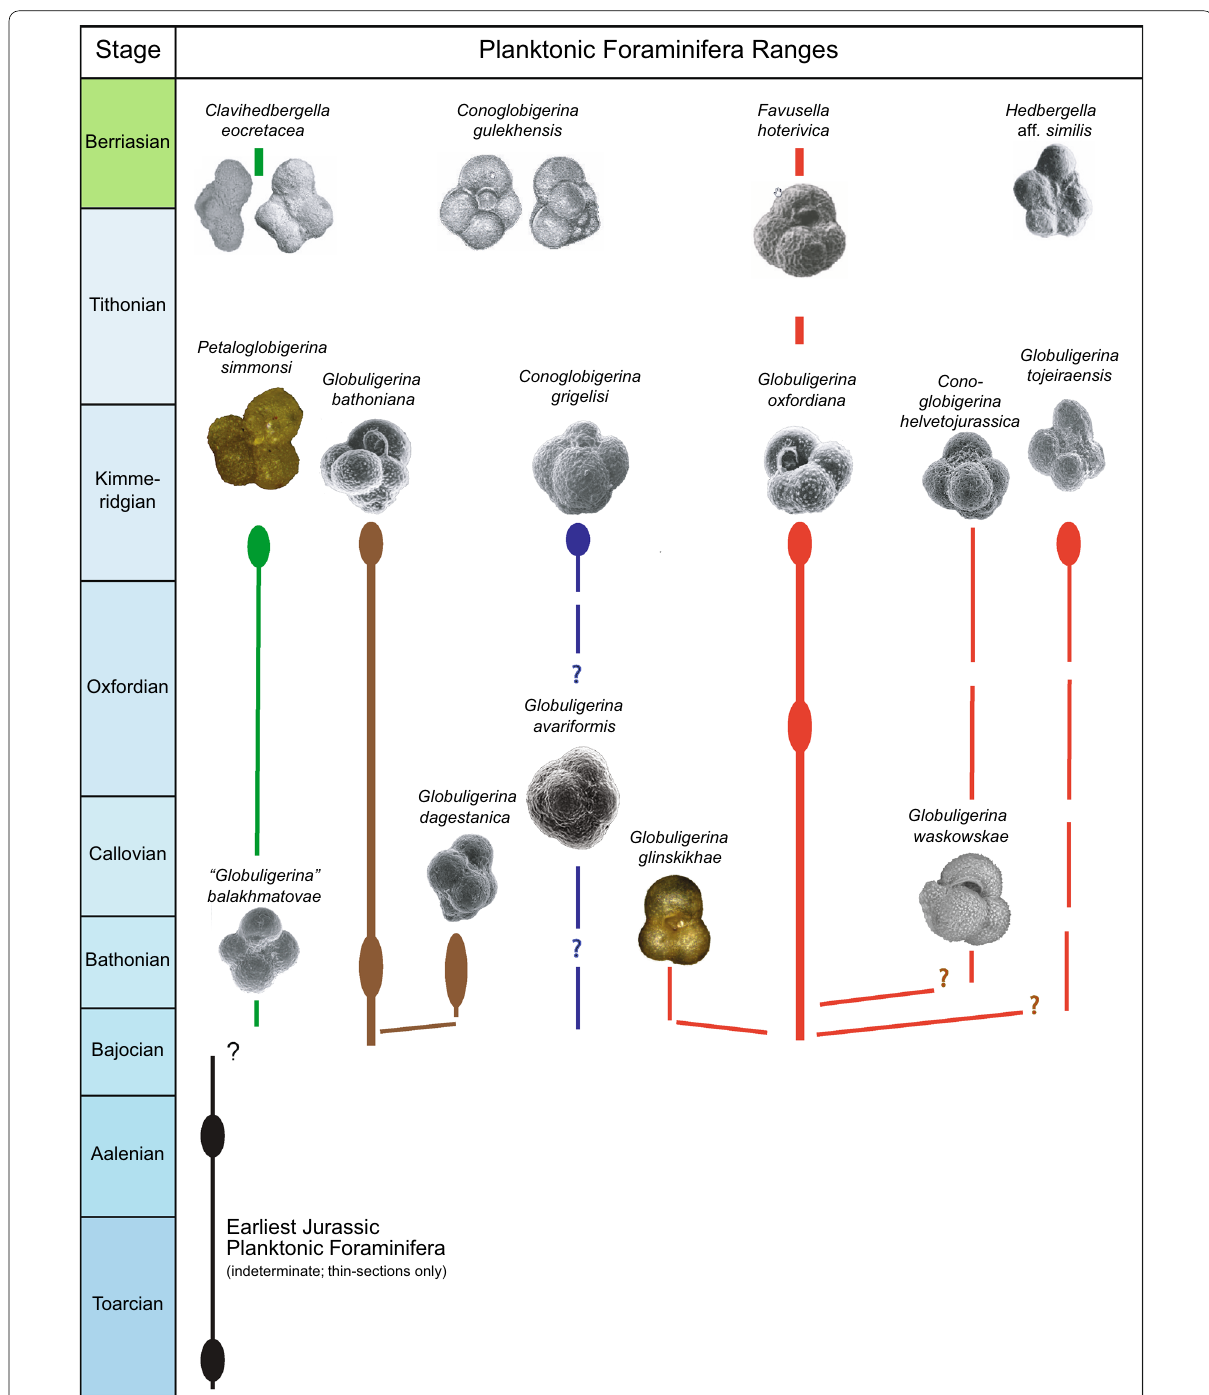
Fig. 6 Stratigraphic ranges and evolution of Jurassic planktonic foraminifera. For details, see